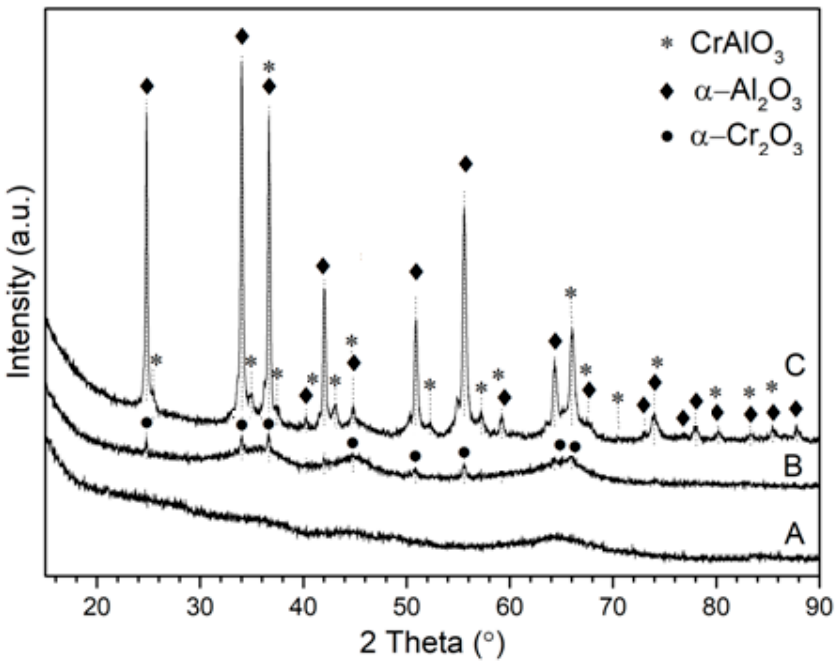
Figure 1. XRD patterns of the sample after calcination at 400 °C ( A ) and after subsequent reduction at 600 °C ( B ) and 800 °C ( C ).